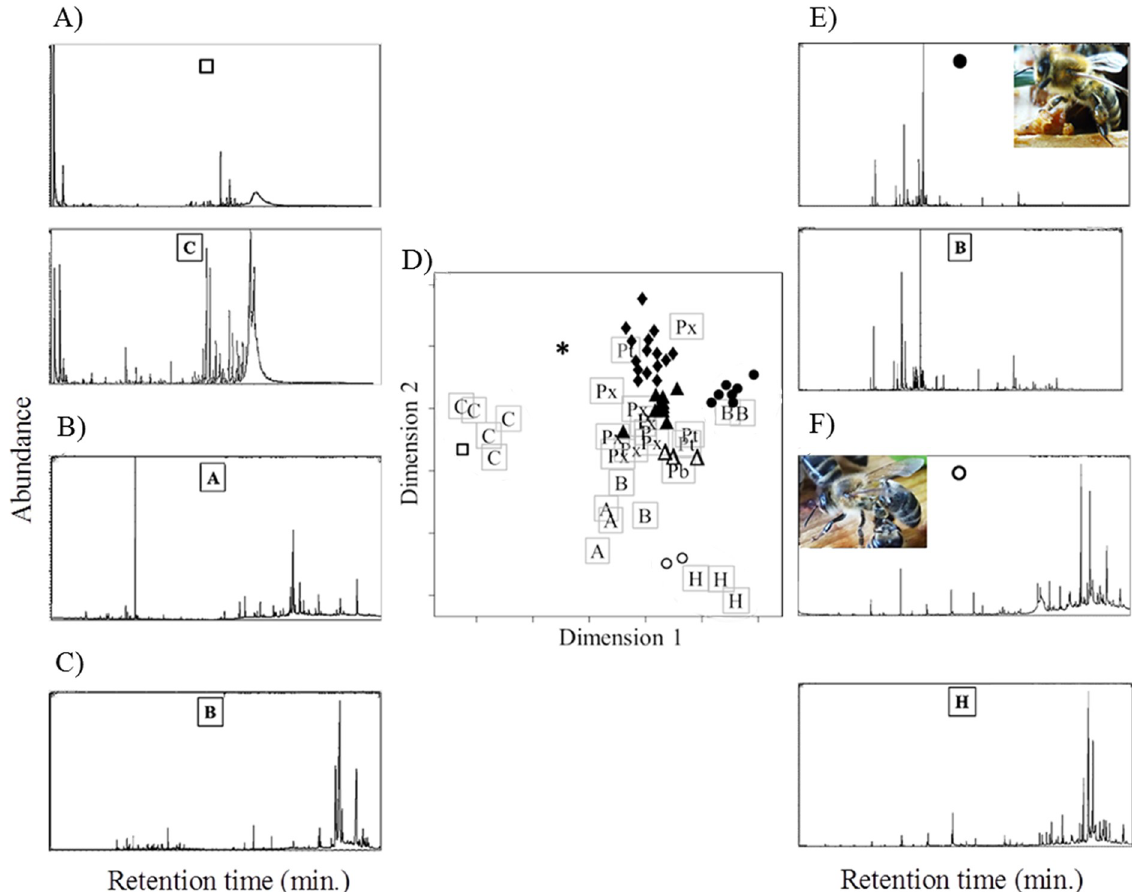
Fig 6. Similarity in chemical composition of tree bud resins and bee-collected resins. Tree bud resins (letters in ordination Figure; n = 30) and bee-collected resins (symbols; n = 39) from 17 colonies at seven different apiaries/sites. Ordination Figure (D) is based on Bray-Curtis dissimilarities between samples (stress value = 0.20). Different letters indicate different tree species: C, conifers ( Picea abis / Pinus sylvestris ); Pb, Populus balsamifera ; Px, Populus x canadensis ; Pt, Populus tremula ; B, Betula alba ; A, Alnus glutinosa ; H, Aesculus hippocastanum . Different symbols represent different resin types: closed circle: “brown”; closed diamond: “ocher”; closed triangle: “orange”; open triangle: “red”; star: “yellow”; open circle: “clear”; open square: “whitish”. A)—F) Exemplary chromatograms of hexane extracts from tree bud resins and bee-collected resins: A) top: corbicula resin “whitish”, bottom: P . abis ; B) A . glutinosa ; C) B . alba ; E) top: corbicula resin “brown”, bottom: B . alba ; F) top: corbicula resin “clear”, bottom: A hippocastanum ; chromatograms display retention times in minutes on the x-axis and mass current (mc) on the y-axis; pictures in chromatograms show examples of resin foragers carrying the respective resin type.